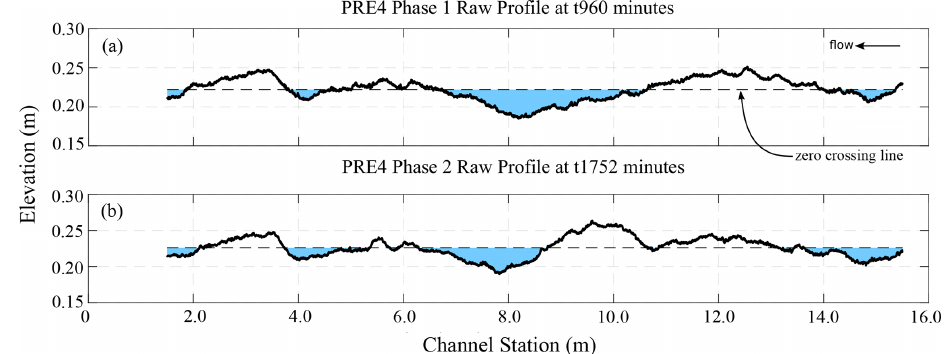
Figure 4. Detrended bed elevation profiles showing a zero-crossing line for Phases 1 and 2 of PRE4. (a) Bed elevation profile at t 960min and (b) t 1752min, each calculated as width-averaged elevations at a resolution of 2mm. Both profiles are fit with a zero-crossing line (Richards, 1976). The elevation profiles do not have a trend and were sampled from the raw digital elevation models (see Chartrand et al., 2018, for more details regarding measurement methods for flume bed elevations). Pool-like features are shown with blue shading below the zero-crossing